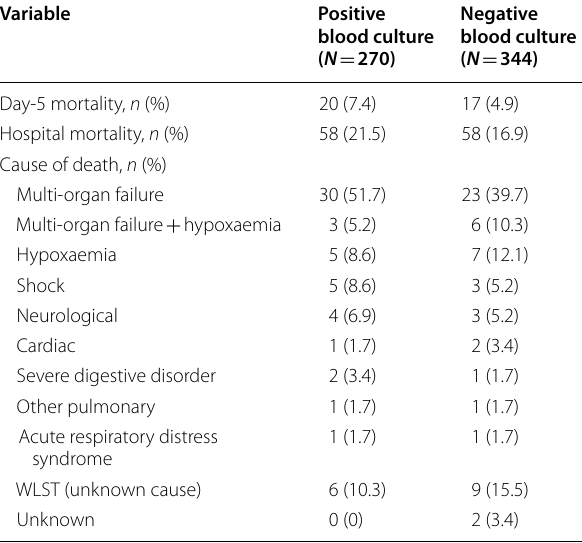
Table 3 Mortality and causes of death